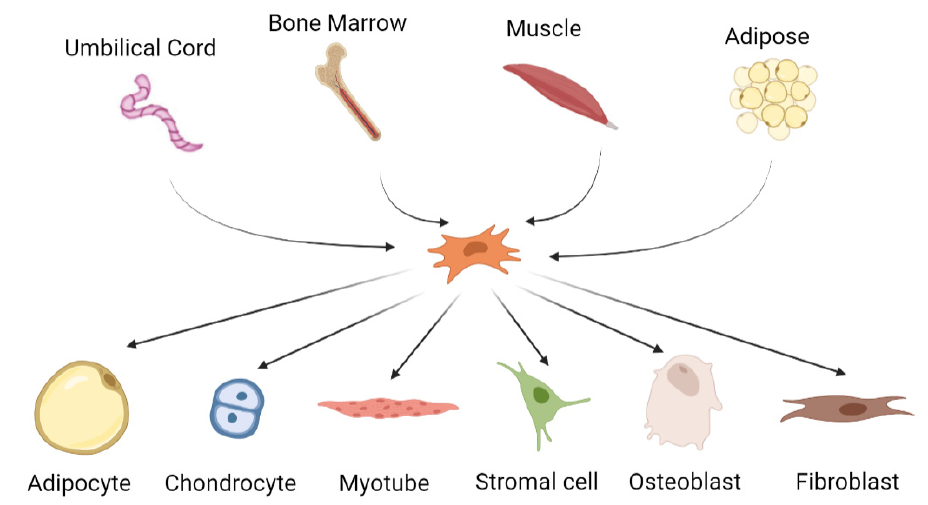
Figure 2. The origin and differentiation potential of mesenchymal stem cells.